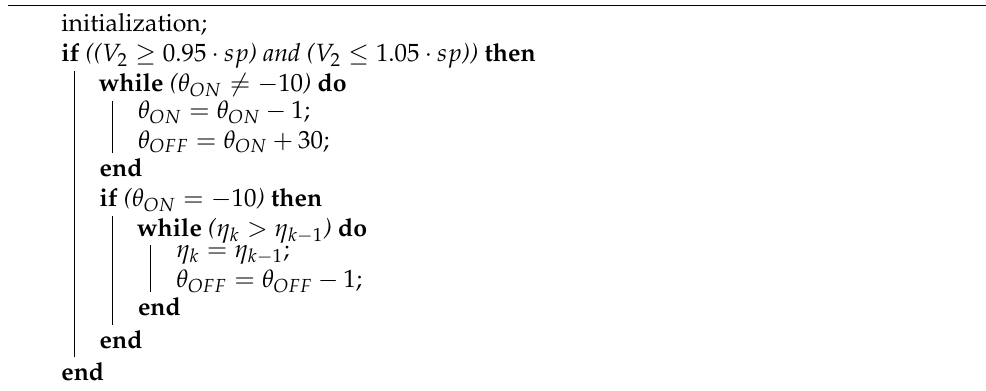
Algorithm 1: Maximum Efficiency Point Tracking (MEPT)